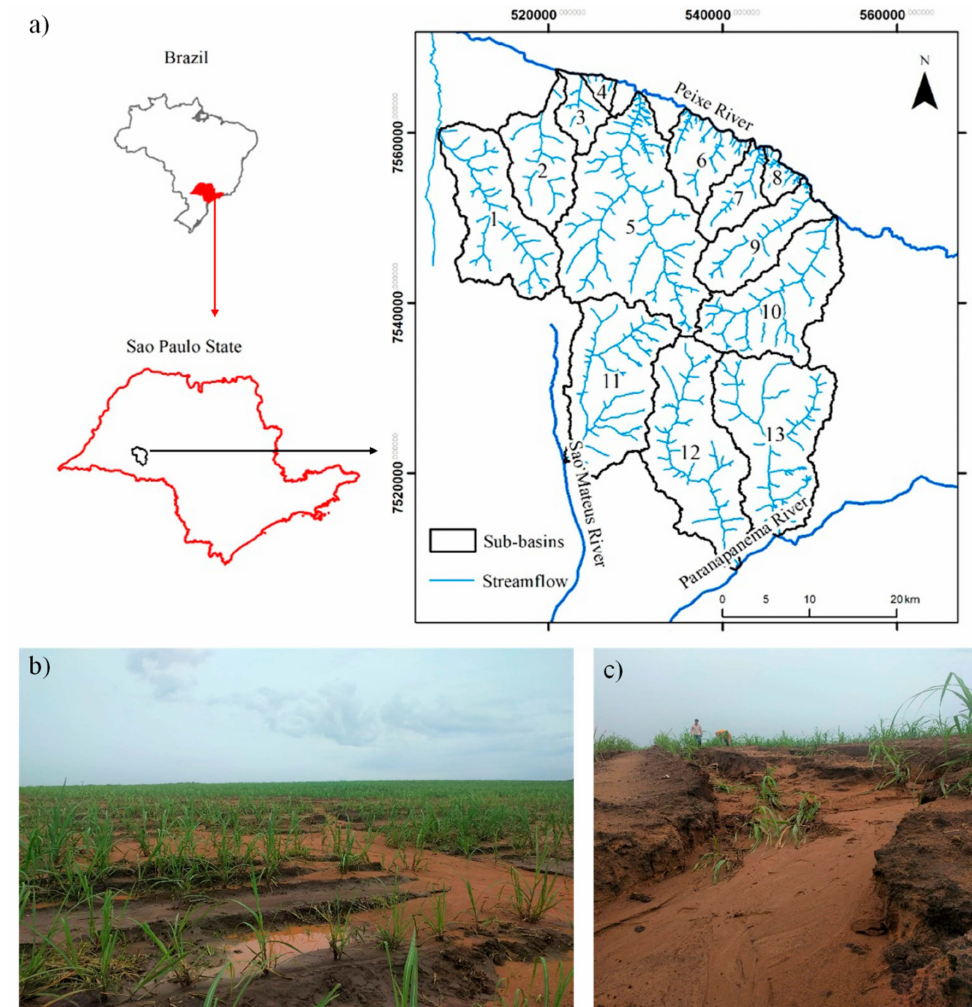
Figure 1. ( a ) Study location, ( b ) sheet and interrill erosion process and ( c ) gully erosion development during the rainy season at the beginning of the plant cane harvest under conventional